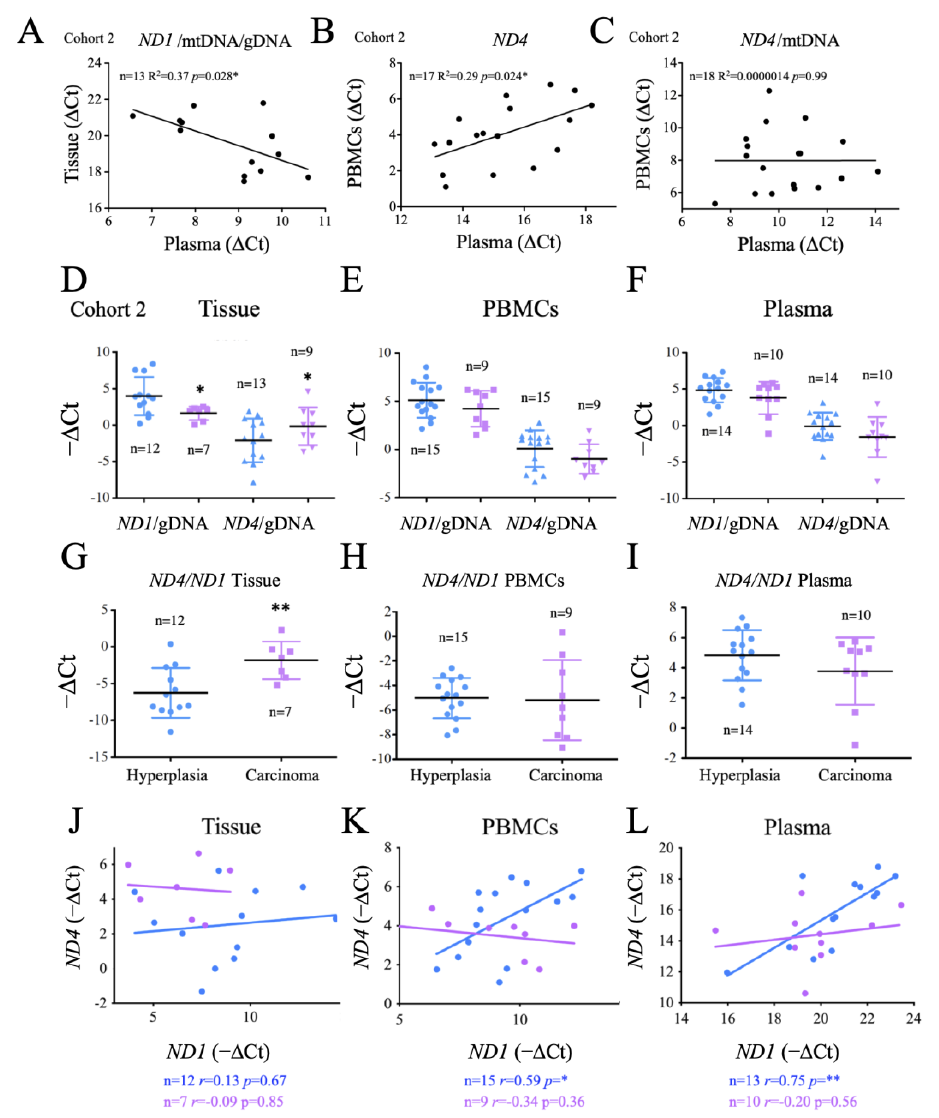
Figure 6. Comparative analysis of mtDNA genes ND1 and ND4 in patients with carcinoma and hyperplasia reveals different ratios and correlation indices in thyroid tissues and PBMCs. ( A ) Correlation and linear regression analysis of ND1 /mtDNA/gDNA in plasma vs. thyroid tissue samples. ( B ) Correlation and linear regression analysis of ND4 in plasma vs. PBMC samples. ( C ) Correlation and linear regression analysis of ND4 /mtDNA in plasma vs. PBMC samples. ( D ) Ratios ND1/ gDNA and ND4 /gDNA in thyroid tissue samples. ( E ) Ratios of ND1/gDNA and ND4 /gDNA in PBMC samples. ( F ) Ratios of ND1 /gDNA and ND4 /gDNA in plasma samples. ( G ) Ratios of ND4/ND1 in thyroid tissue samples. ( H ) Ratios of ND4/ND1 in PBMC samples. ( I ) Ratios of ND4/ND1 in plasma samples. ( J ) Correlation and linear regression analysis of ND1 vs. ND4 in thyroid tissue samples. (K) Correlation analysis of ND1 vs. ND4 in PBMCs samples. ( L ) Correlation and linear regression analysis of ND1 vs. ND4 in plasma samples. Data are mean ± standard deviation (SD). *, p < 0.05; **, p ≤ 0.01.